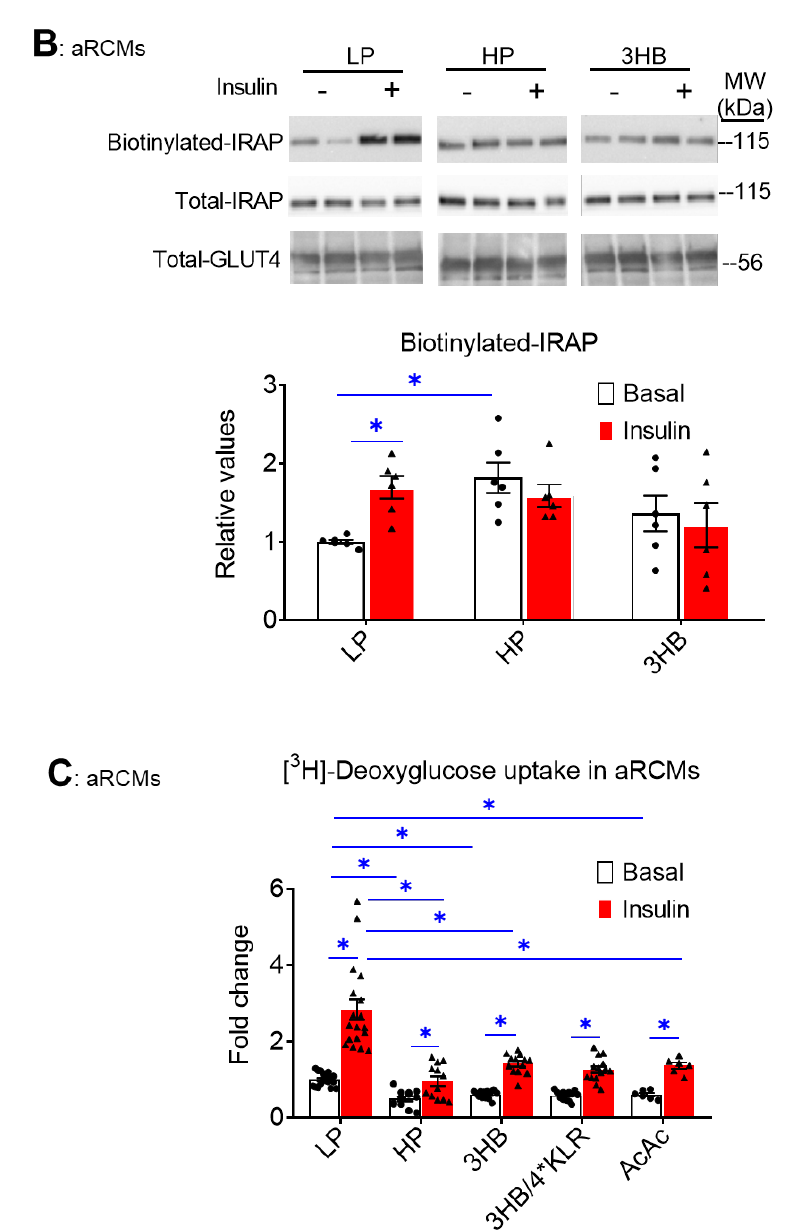
Figure 4. Chronic 3HB exposure prevents insulin-stimulated GLUT4 translocation and glucose uptake in cardiomyocytes. ARCMs were cultured for 24 h in either low palmitate medium (LP; control condition), high palmitate medium (HP), LP with 3 mM 3HB (3HB); LP with 3HB in the presence of 4*KLR (3HB/4*KLR); or LP with 3 mM acetoacetate (AcAc). ( A , B ) After 24 h, cells were short-term (30 min) incubated without/with 100 nM insulin. ( A ) Microscopical assay of cell-surface GLUT4. aRCMs were transduced for 24 h with an adenoviral vector containing an HA-GLUT4-GFP fusion protein before the start of the culturing. Non-permeabilized cells were anti-HA immunostained. The nuclei are stained in blue (DAPI). Representative microscopical images are displayed (the scale bar is 50µm). The ratios of red (HA-tag) and green (GFP) intensity per pixel were quantified by Image J (n = 6). ( B ) Biotinylation assay. Representative Western blot and quantification of insulin-regulated aminopeptidase (IRAP, which reflects GLUT4 translocation) in biotin-immunoprecipitations and in total lysates (n = 6). ( C ) [3H]Deoxyglucose uptake (n ≥ 6). Bar values are means ± SEM. * p < 0.05. The dots represent the measurements that are performed under ‘basal’ condition. The triangles represent the measurements that are performed after insulin